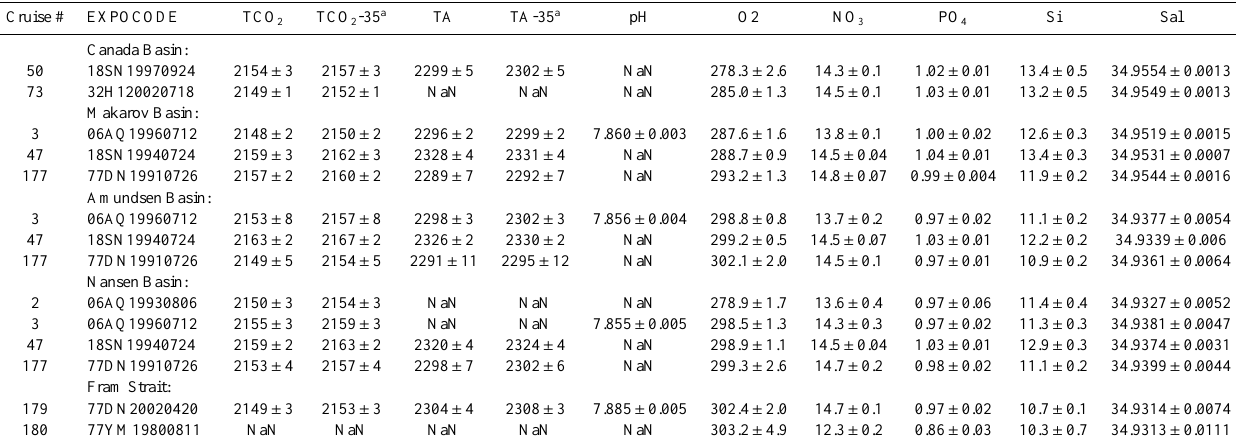
Table 2. Deep-water averages (depth > 2500m).